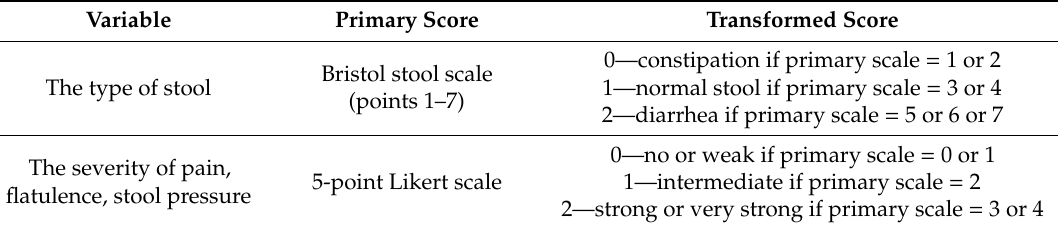
Table 2. Scores assessing the type of stool and the severity of irritable bowel syndrome (IBS) symptoms based on the information obtained by telephone interviewers after transformation for statistical